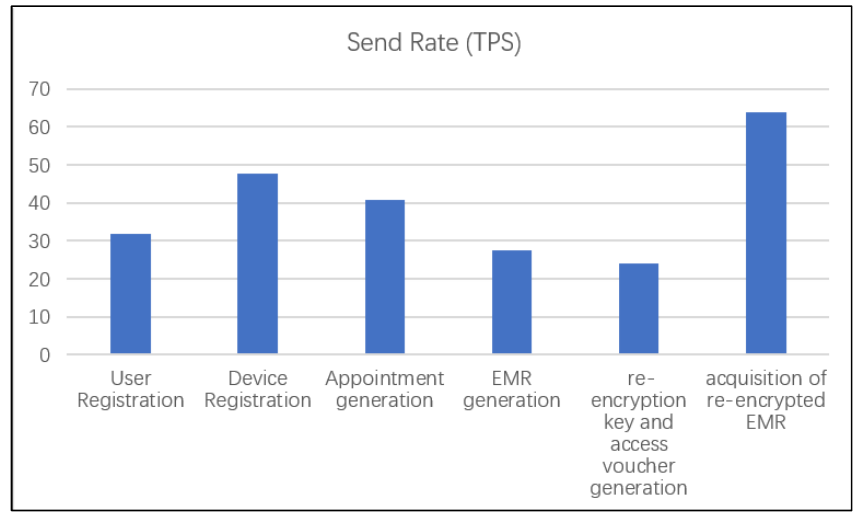
Figure 13. Send rate (TPS).